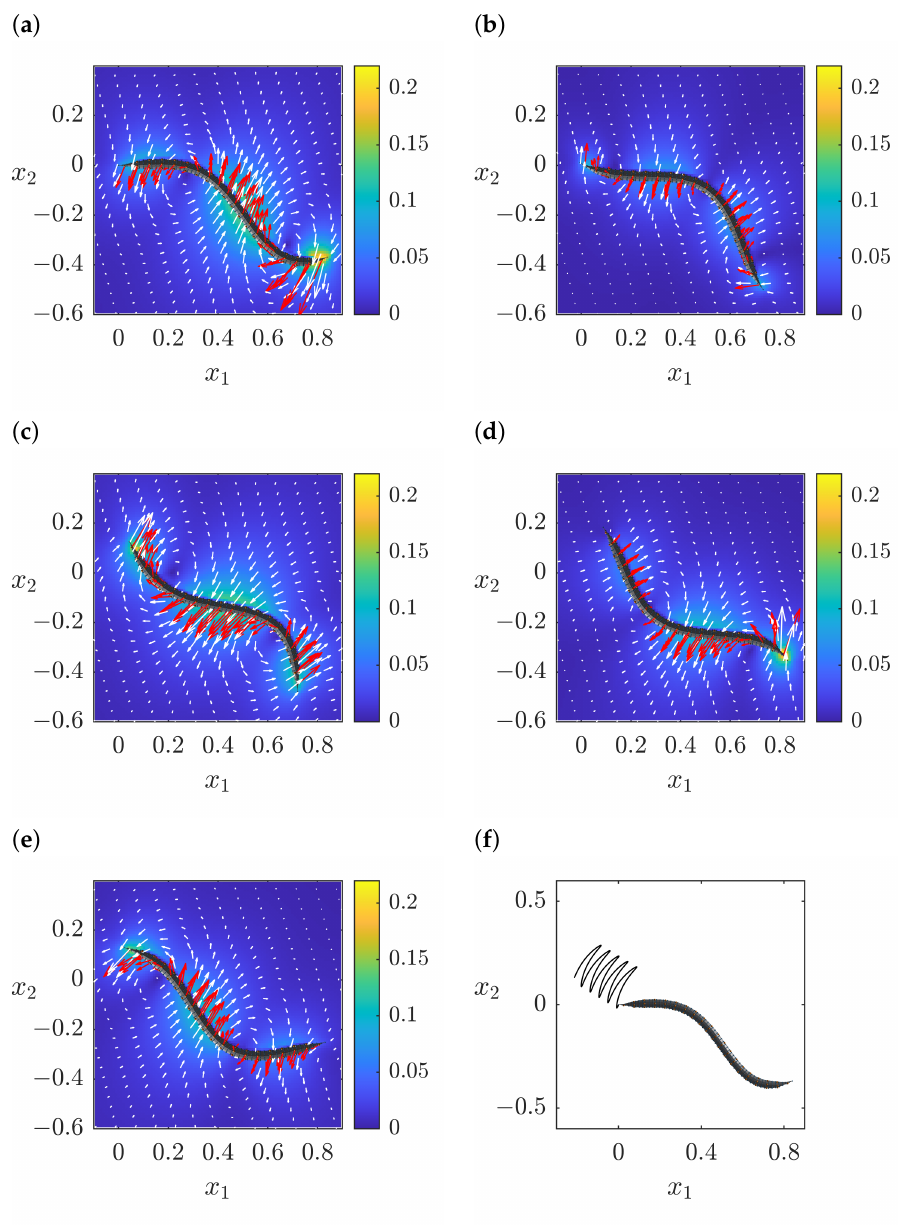
Figure 6. Undulating slender swimmer, full boundary integral calculation, with maximum radius a 0 = 0.02. ( a – e ) velocity field on the swimmer and in the fluid at five approximately equally spaced intervals during the beat cycle. ( f ) Trajectory of the leading point over four beat cycles (black solid line) and initial discretisation, with force points shown in red and quadrature points in